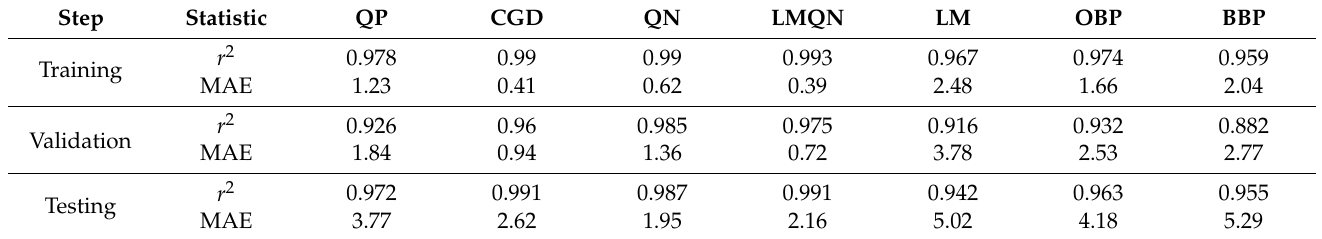
Table 4. Coefficients of determination and mean absolute error of the ANN training